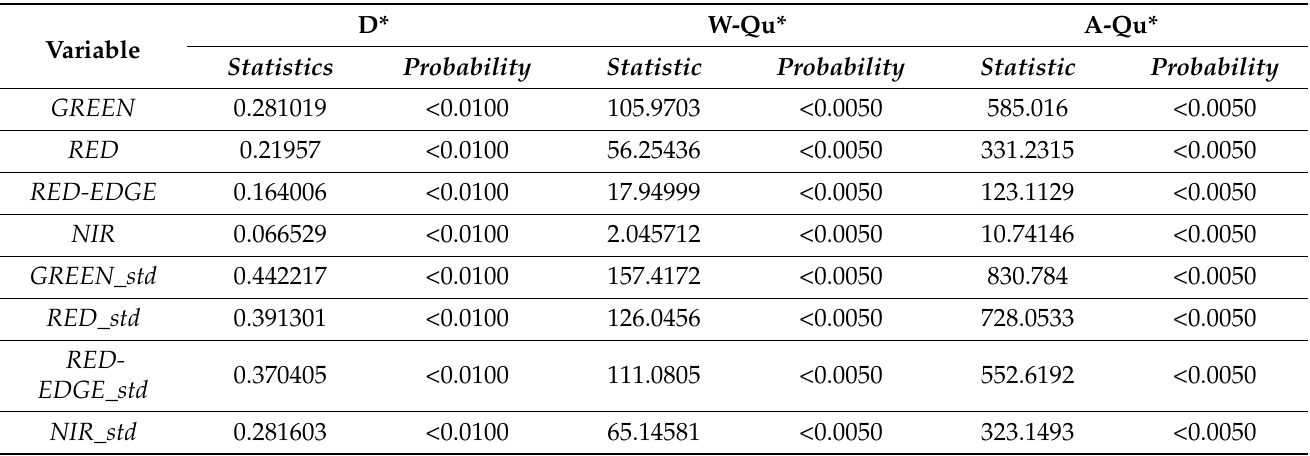
Table 2. Normality tests for the radiometric variables.